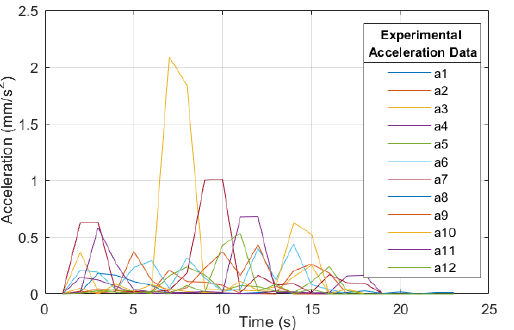
Figure 5. Superposition of samples of cardiac accelerations (experimental data).